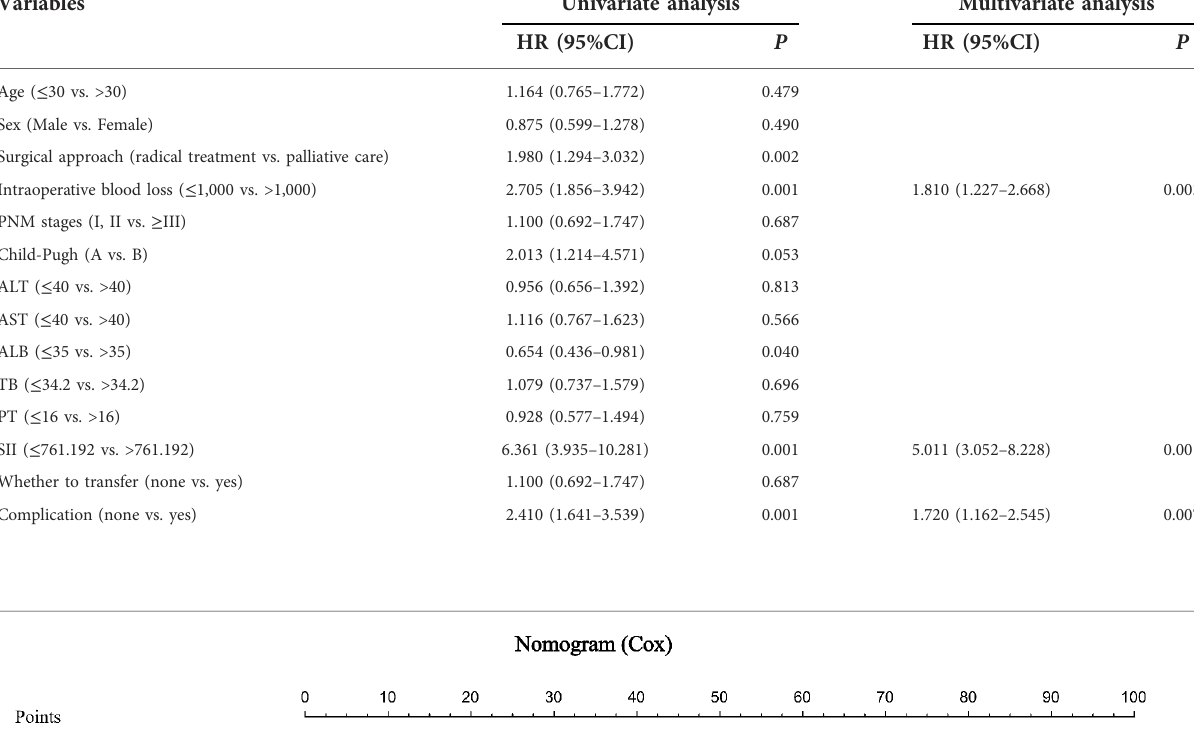
TABLE 2 Univariate and multivariate analysis on the survival of patients with hepatic alveolar hydatid disease.